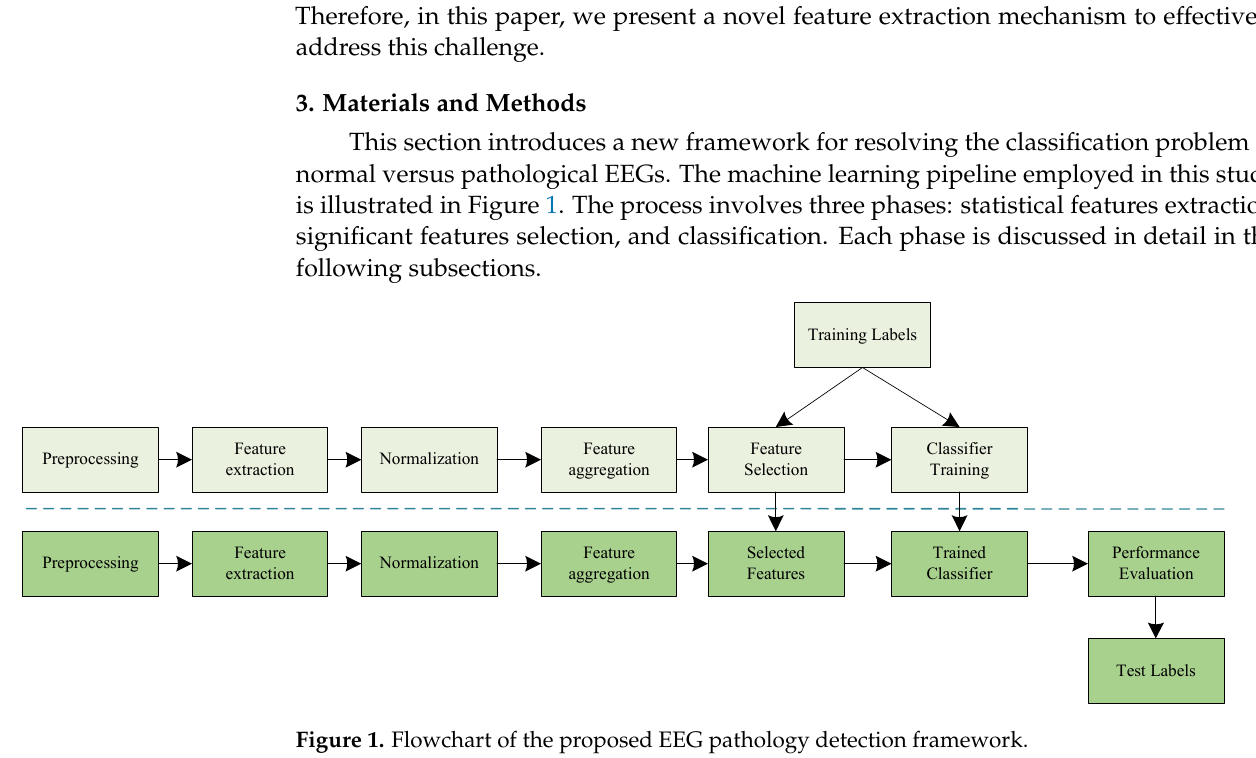
Figure 1. Flowchart of the proposed EEG pathology detection